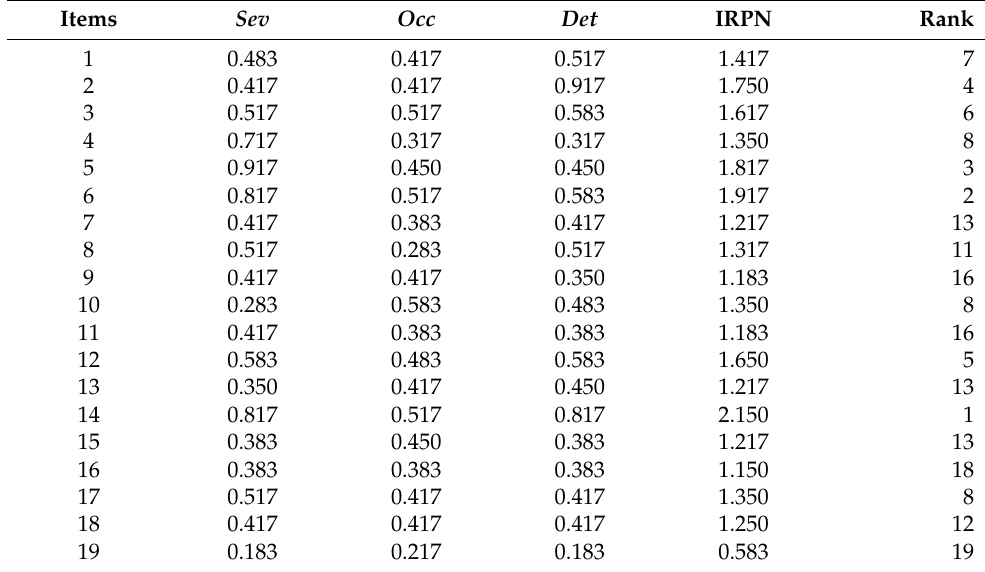
Table 4. The IRPN value of the electronic equipment new product design